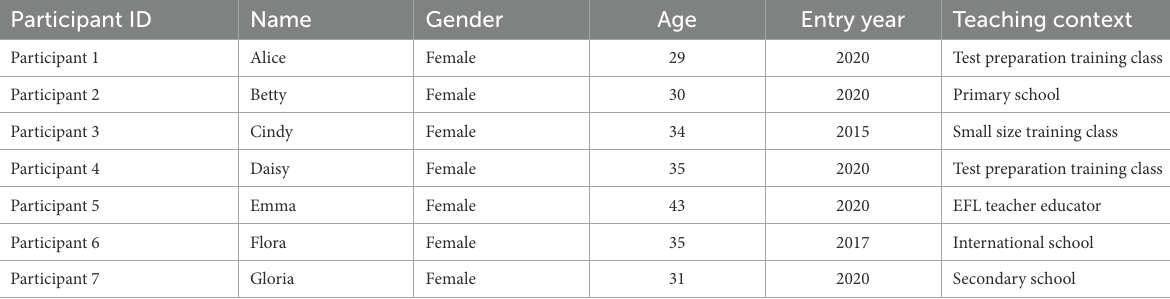
TABLE 3 Participant demographic